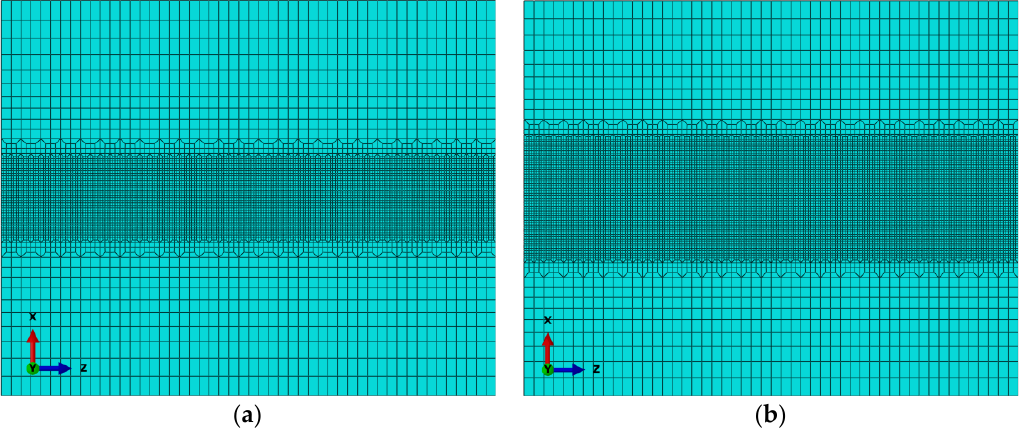
Figure 9. Welding finite element model: ( a ) LBW, ( b ) TIG welding.